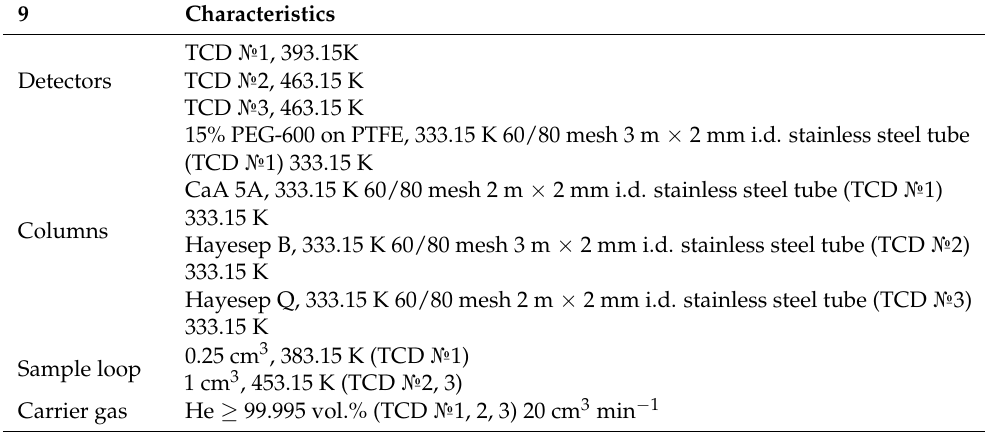
Table 2. GC analysis details used for membrane-assisted gas absorption cell separation performance test.